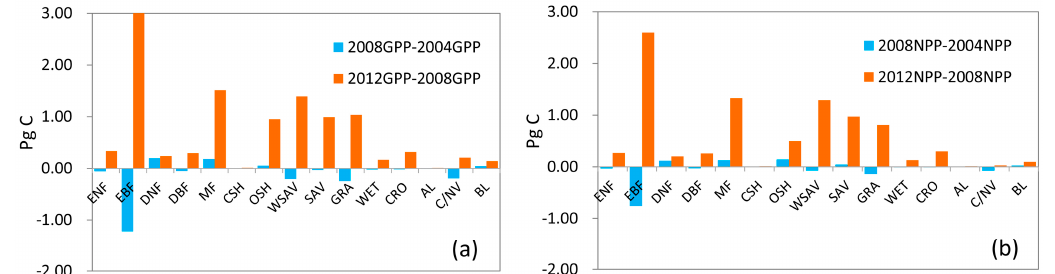
Figure 7. Variation in global total GPP and NPP for all vegetated land cover types: ( a ) variation in global GPP; ( b ) variation in global NPP.